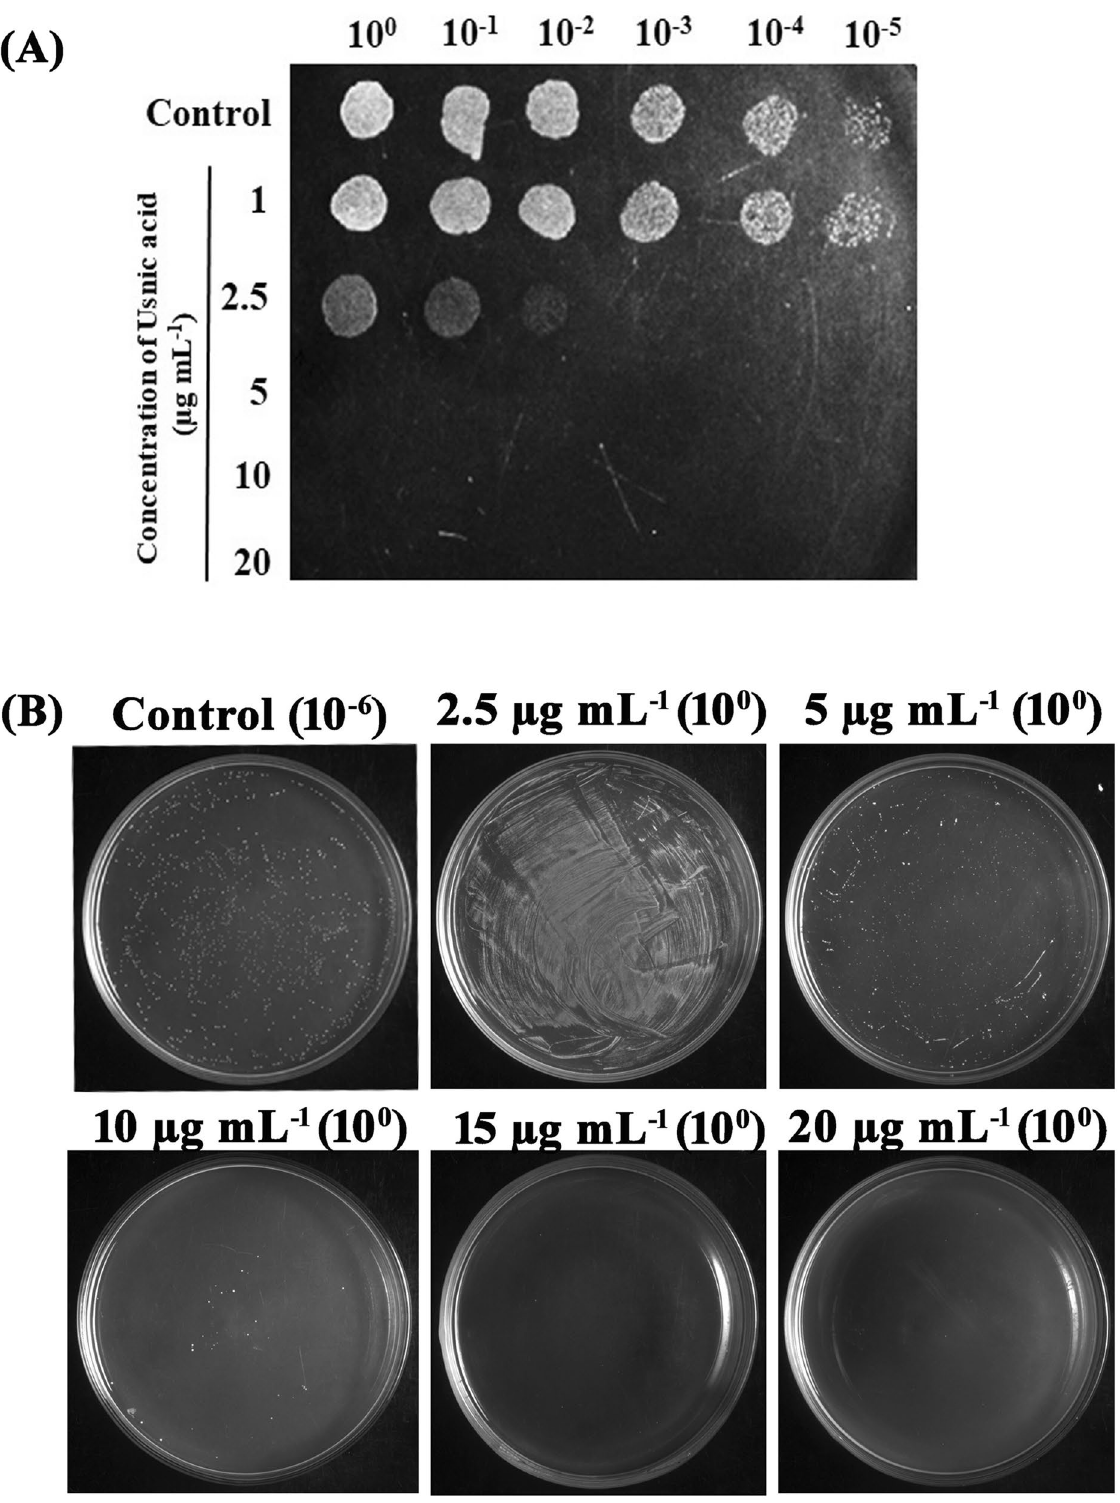
Figure 2. Bactericidal activity of UA on S. mutans. (A) Spot assay to validate the bactericidal activity of UA (B) MBC was determined through cfu assay. From 10 µg mL −1 , UA was found to be bactericidal against S.